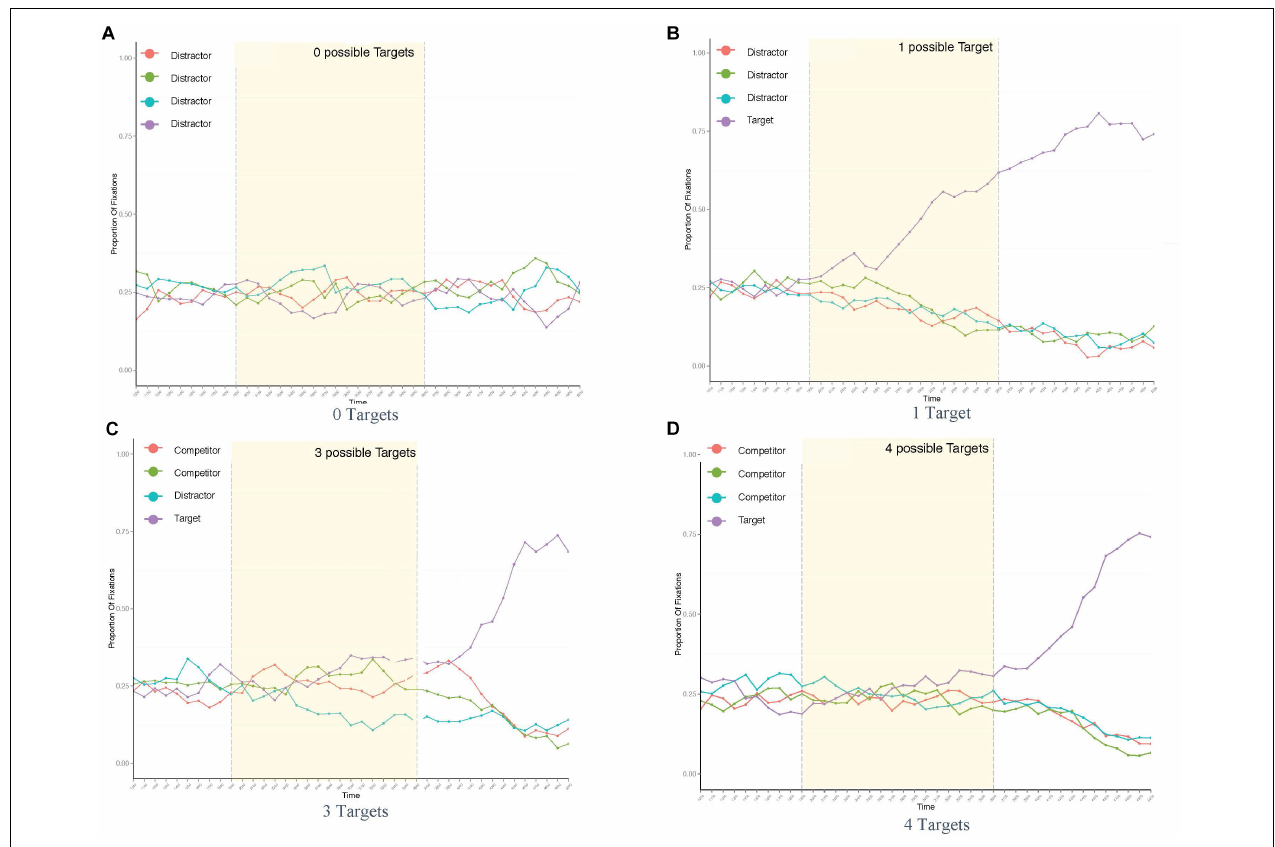
FIGURE 8 | Proportion of fixations across trial length in all conditions of Experiment 4 : with 0 targets (A) , 1 displayed target (B) , 3 targets (C) , and 4 targets (D)